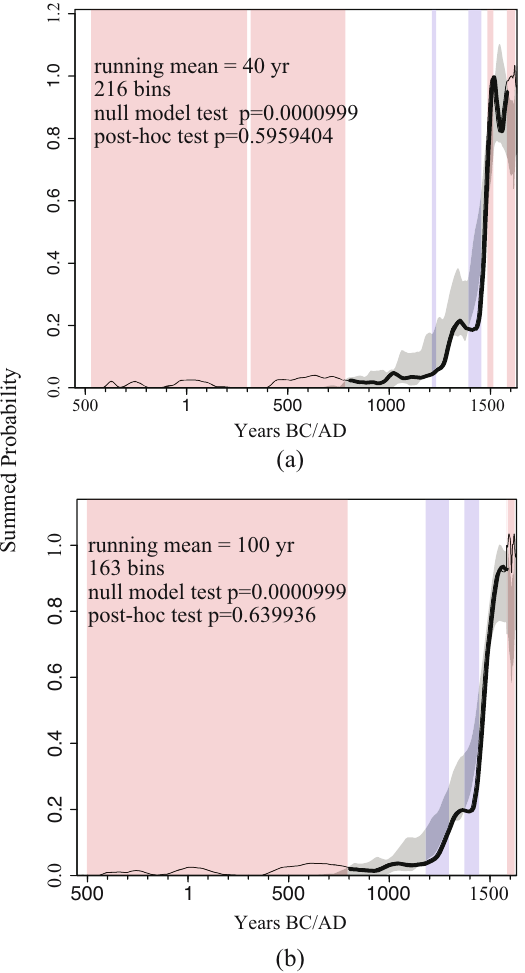
Figure 5: Test of maize SPD against null exponential model based on 10,000 simulations with unnormalized date calibrations and SPDs ( a ) 40 year running mean, ( b ) 100 year running mean. The solid lines are the SPDs and the gray bands are the simulation envelopes. Blue vertical bands denote negative departures and red bands positive departures of the SPDs from the simulation envelopes. Post hoc test range ( AD 800 – 1570 ) indicated with heavy black